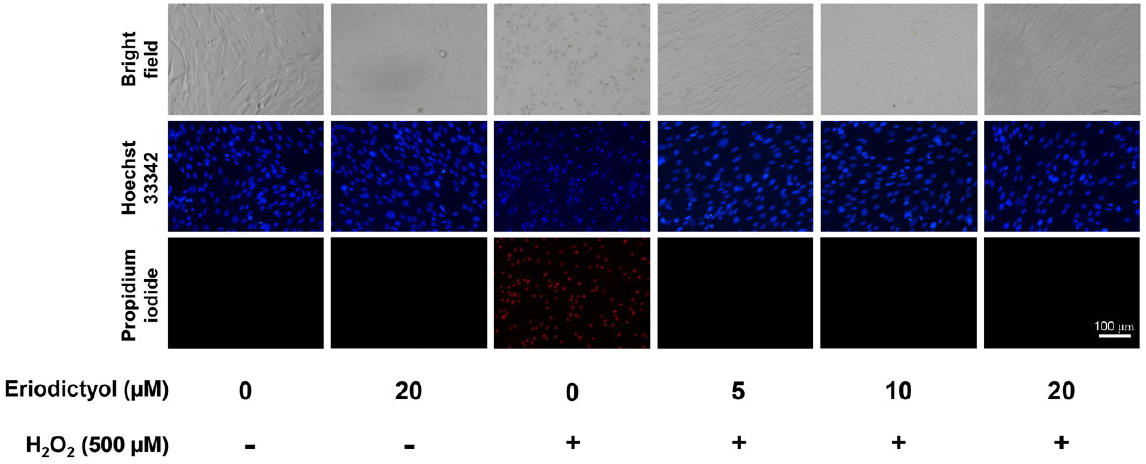
Figure 2. Eriodictyol prevented the induction of necrosis in BJ cells following H 2 O 2 treatment. BJ cells were pre-treated with eriodictyol (5–20 µM; 24 h) followed by H 2 O 2 treatment (500 µM; 1h). After 24 h treatment with H 2 O 2 , dermal fibroblasts were co-stained with Hoechst 33342 (blue)/PI (red) to characterize mode of cell death ( n = 3; magnification = 20×; scale bar = 100 µm).